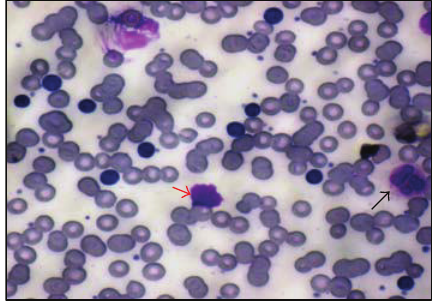
Inset Figure 5: FNAC from axillary lymph mode showing monotonous population of small lymphoid cells admixed with occasional immunoblasts, mildly enlarged lymphoid cells with finely clumped chromatin and prominent nucleoli (Giemsa, × 10; inset ×